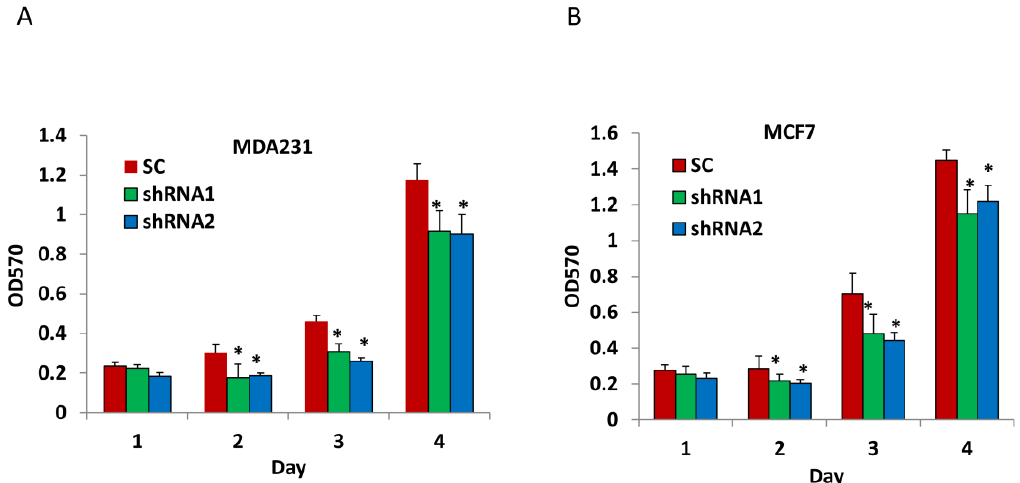
Figure 2. Silencing CLDN1 inhibits proliferation of breast cancer cells. ( A , B ) The proliferation of MDA-MB-231 cells ( A ) and MCF7 ( B ) transduced with different CLDN1 lentiviral shRNAs and SC control were examined by MTT assays. Data were presented as mean ± SD from three independent experiments (* p < 0.05).